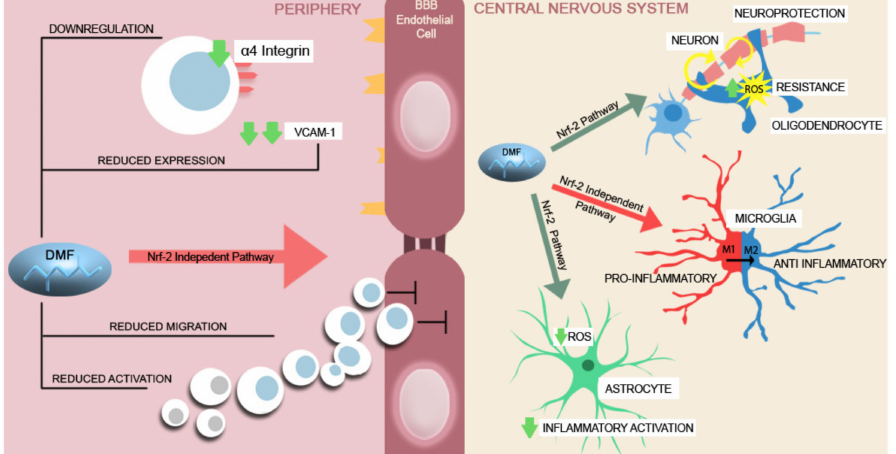
Figure 2. A brief schematic representation of DMF’s mechanism of action. In the peripheral compart- ment, DMF induces changes in the immune response by decreasing the activation and migration of Th lymphocytes. It further alters the transendothelial migration across the BBB, reduces the expression of the adhesion molecules, such as VCAM-1, and downregulates the α 4 integrin on the lymphocyte surface [81,82,84,85,88,89]. Inside the CNS, DMF carries Nrf-2 dependent neuroprotective effects upon the neurons and oligodendrocytes by increasing the ROS resistance of the neurons and glial cells and upon the astrocytes by decreasing the proinflammatory cytokine secretion and intracellular ROS production [86,90,91]. In proinflammatory activated microglia, DMF reduces the production of proinflammatory mediators and stimulates the shift from a M1 proinflammatory state to a M2, anti-inflammatory state